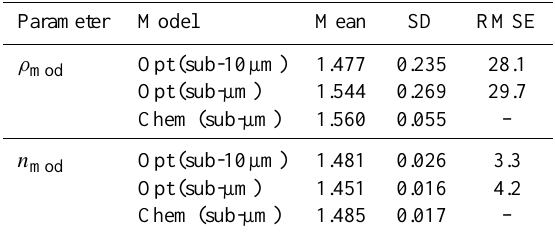
Table 2c. The same as Table 2a but for retrievals under wet condi- tions (133 points; RH = 65.7 ±